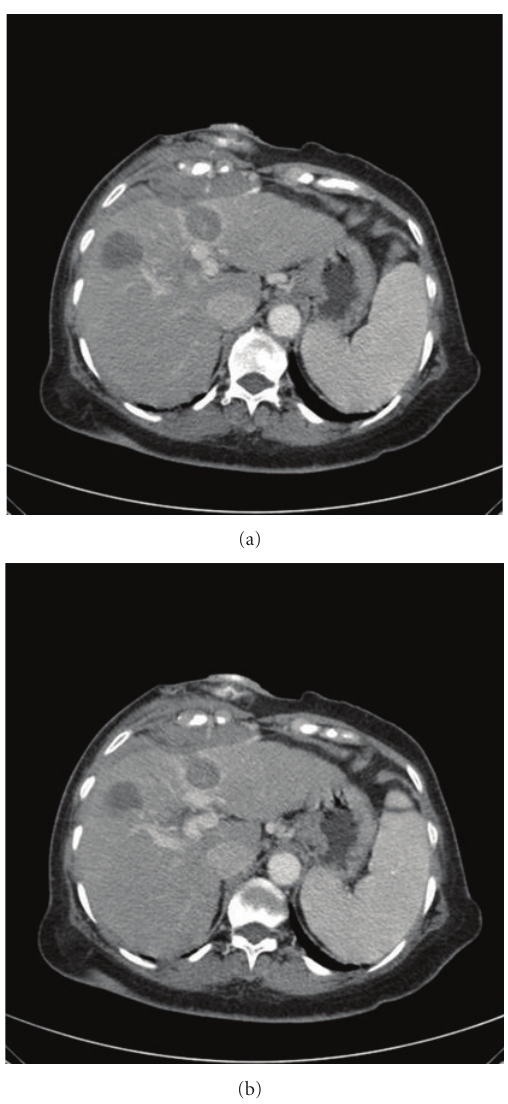
Figure 3: A dual-phase dynamic contrast-enhanced CT was per- formed just after the RFA procedure which revealed a jet-like ex- travasation from the intercostal vessels.